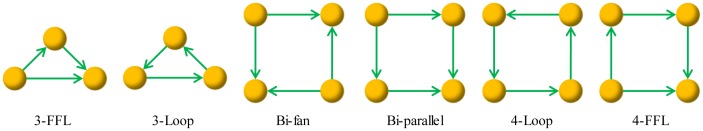
All the six minimal loop-embedded subgraphs of orders 3 and 4.They are named after Ref. [29], where 3-FFL and 4-FFL stand for three-order and four-order feed forward loops, and 3-Loop and 4-Loop mean three-order and four-order feedback loops, respectively.